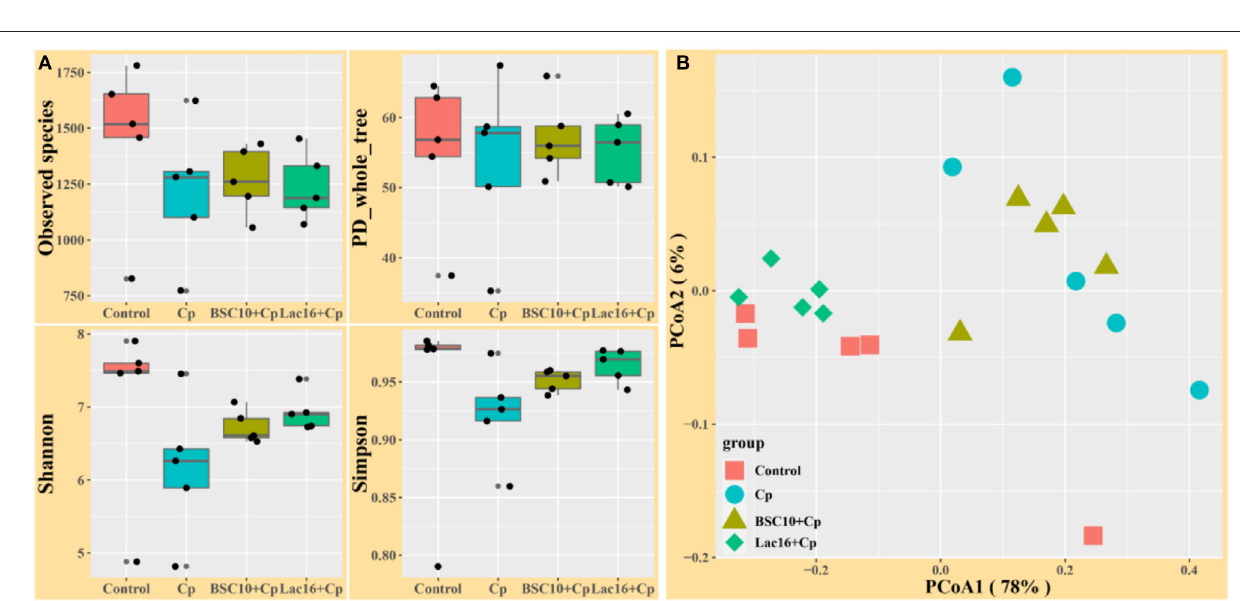
FIGURE 3 | Diversity analyses of microbial communities among groups. (A) Alpha diversity analysis (B) Principal coordinates analysis (PCoA) based on Bray-Curtis distance. n = five samples.